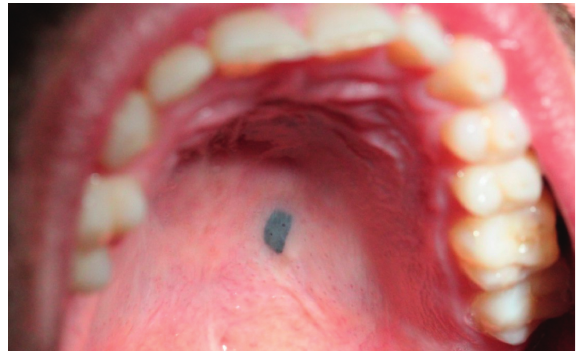
Figure 1: Palatal lesion during oral